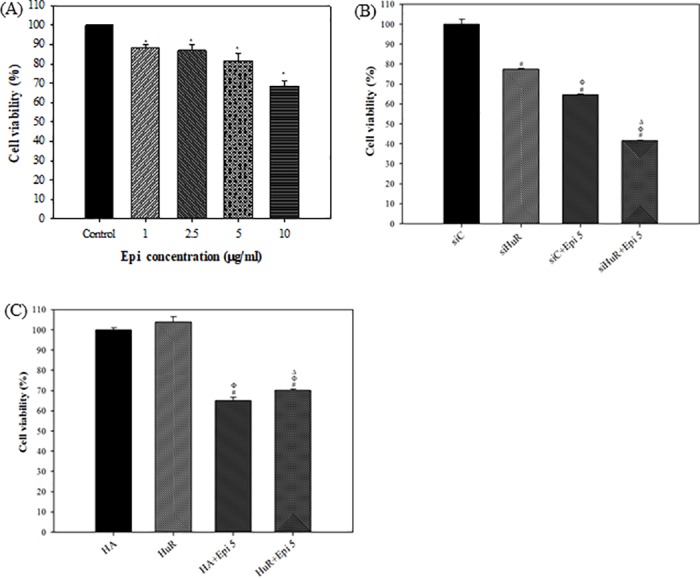
HuR protected SW620 cells from the cytotoxic effect of Epi.(A) The dose-dependent cytotoxic effect of Epi on SW620 cells. Cells were treated with different concentrations of Epi as indicated for 24 h. Cells without treatment were designed as Control. Viable cells were measured by MTT assay. The percentage of cell viability was calculated by setting the Control group as 100%. Data are presented as means ± S.D. from three independent experiments. Each experiment was conducted in triplicate. * P<0.05 compared to the Control group. (B-C) The expression levels of HuR affected the cytotoxic effect of Epi on SW620 cells. Cells were transfected with 75 nM siC or siHuR (B), or with 2 μg/ml HA and HuR (C). After 24 h, cells were treated with Epi (5 μg/ml) for 24 h. Viable cell number was measured by MTT assay. The percentage of cell viability was calculated by setting the siC group (B) or HA group (C) as 100%. Data are presented as means ± S.D. from three independent experiments. Each experiment was conducted in triplicate. (B) HuR knockdown enhanced the cytotoxic effect of Epi.
# P<0.05 compared to the siC group; Φ P<0.05 compared to the siHuR group; Δ P<0.05 compared to the siC + Epi group. (C) HuR overexpression protected cells from the cytotoxic effect of Epi.
# P<0.05 compared to the HA group; Φ P<0.05 compared to the HuR group; Δ P<0.05 compared to the HA + Epi group. HA: pCDNA/HA; HuR: pCDNA/HA-HuR.